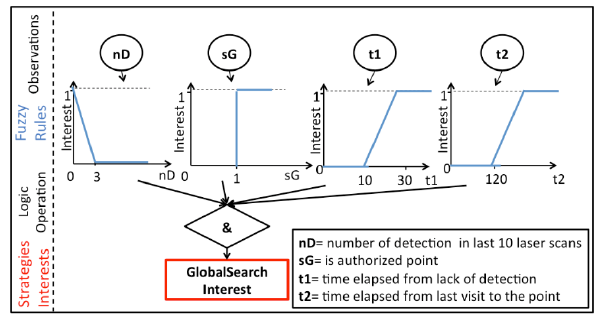
Figure 6. Example of rules associated for the GlobalSearch